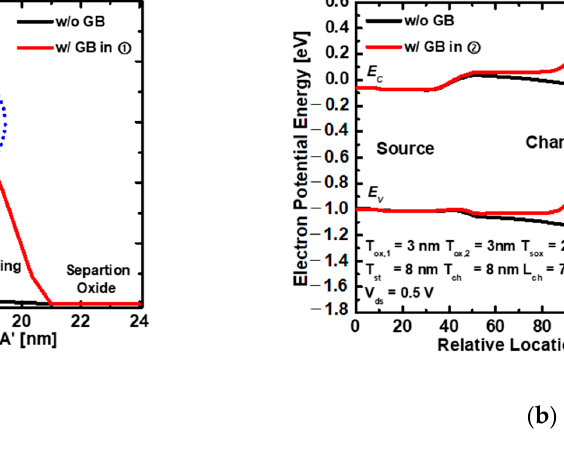
Figure 13. ( a ) SRH recombination of the hold state with and without GB in ① . The energy band is extracted at the center of the storage region. ( b ) Energy band diagram of the read operation with and without GB in ② . The energy band is extracted at 2 nm above the bottom gate oxide.